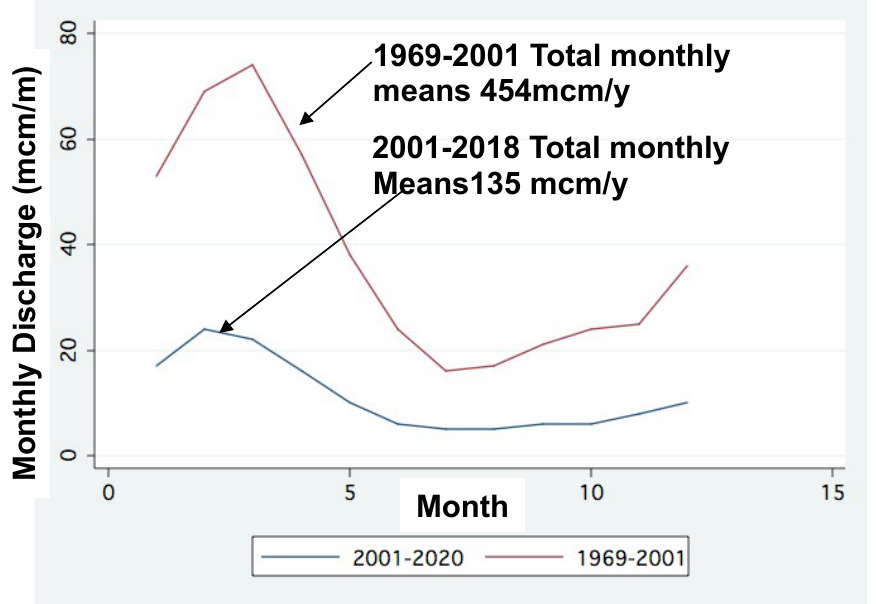
Figure 6. Monthly averages (1969–2001 and 2001–2018) of Jordan River discharge (mcm/m).